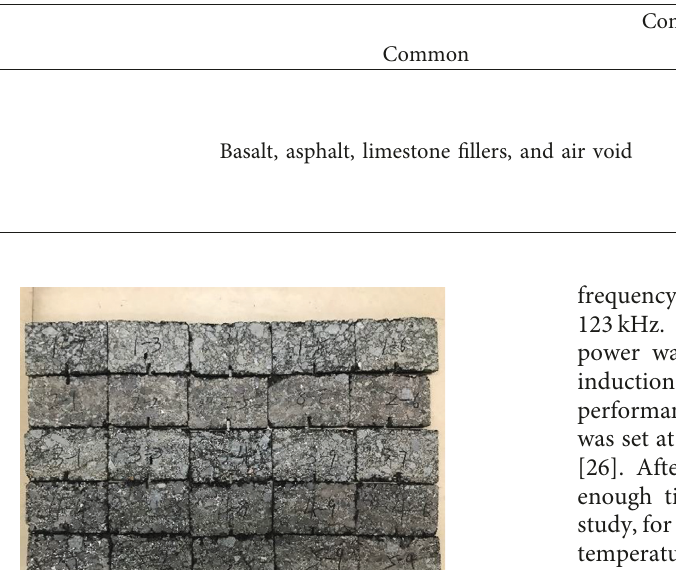
Figure 2: Grading curve of AC-13 basalt asphalt mixture. Table 4: Composition of different kinds of asphalt concrete.